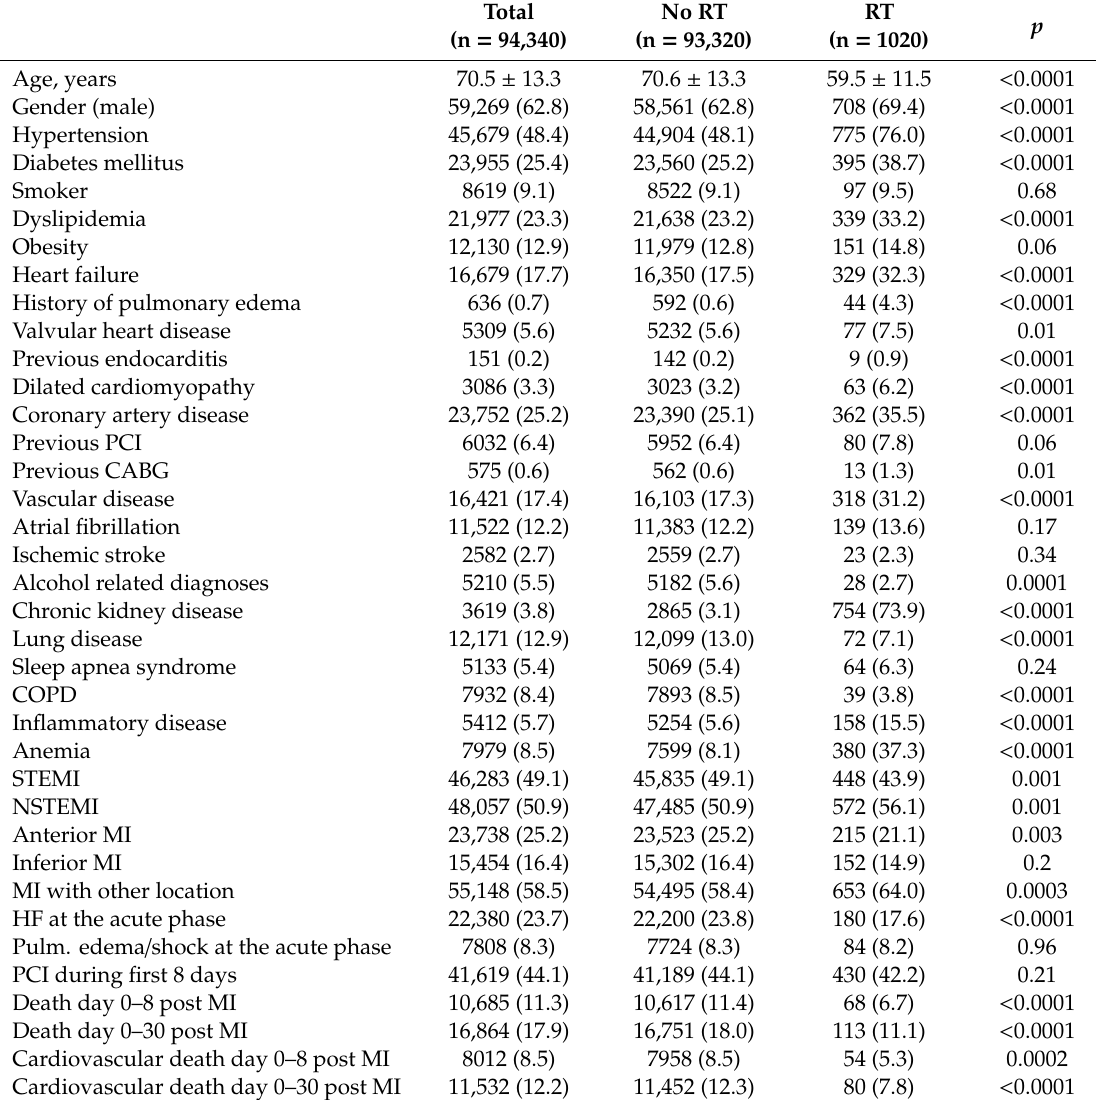
Table 2. Characteristics of patients admitted for acute myocardial